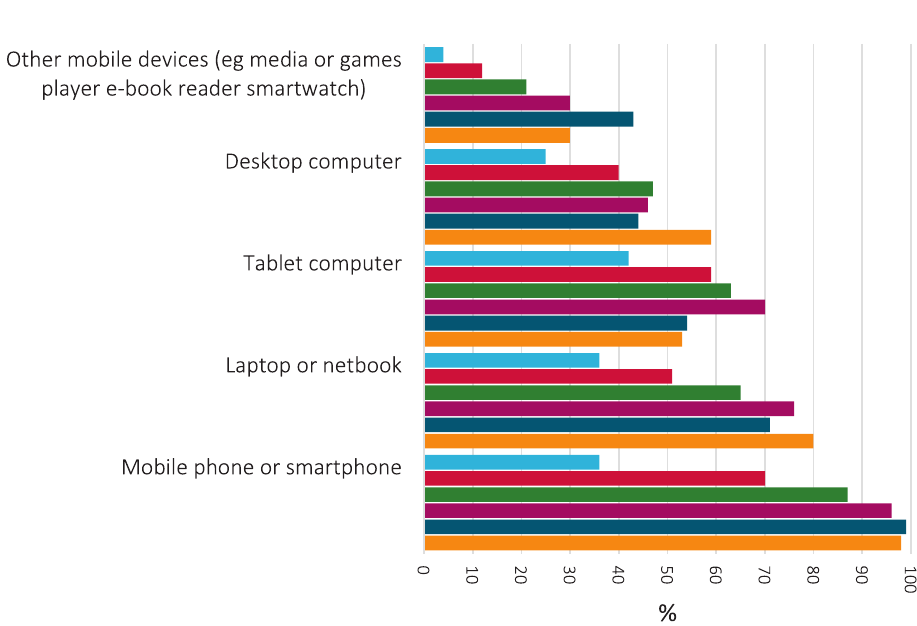
Figure 4. Devices used to access the internet by age group in Great Britain. Source: ONS (2018). age group accessed the internet via a tablet rather than a smart phone (the most widely used internet device across all age groups), 28% of them accessed the inter- net ‘on the go’ using a smart phone. Other statistics in this study showed that online shopping for this cohort rose from 16% to 48% between 2008 and 2018, and that the household goods (25%), clothes or sports goods (24%) and holiday accommodation (24%) were signifi- cant